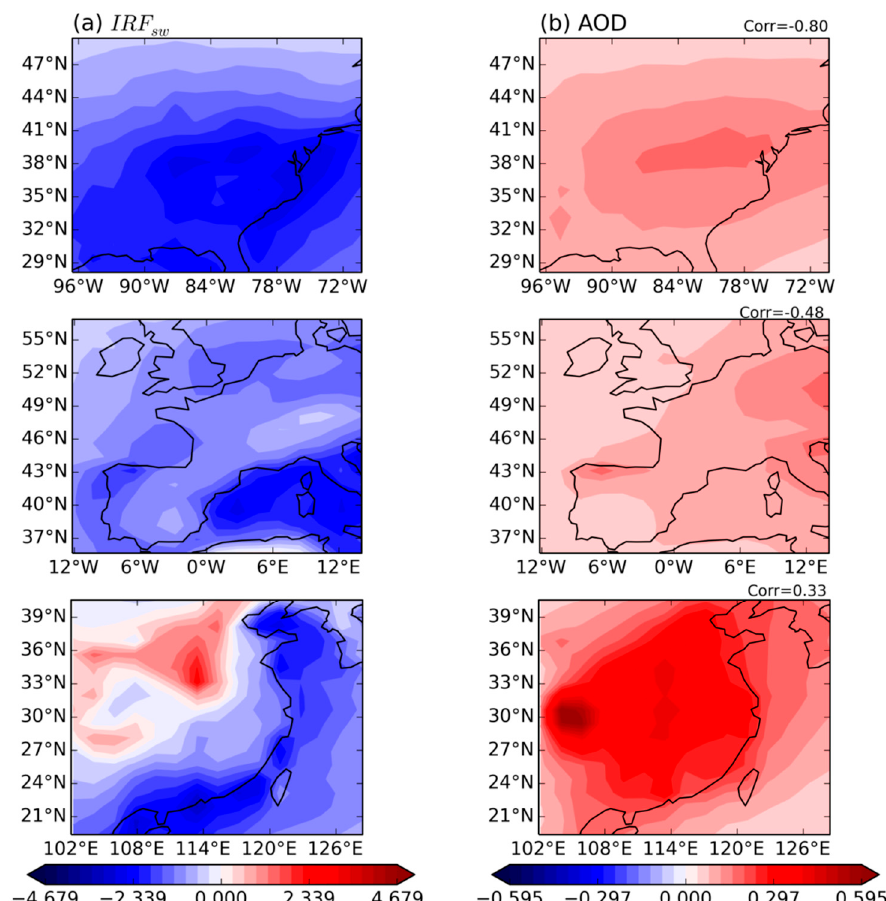
Figure 5. Regional (1st: EUS, 2nd: WEU, and 3rd: ECC) distributions of ( a ) the shortwave instantaneous radiative forcing (IRFsw, W / m 2 ) and ( b ) change in aerosol optical depth (AOD, 1) at 550 nm from the pre-industrial (1850) to the T2 period (1980–2010). Spatial correlation coefficients are shown in the upper right corner.